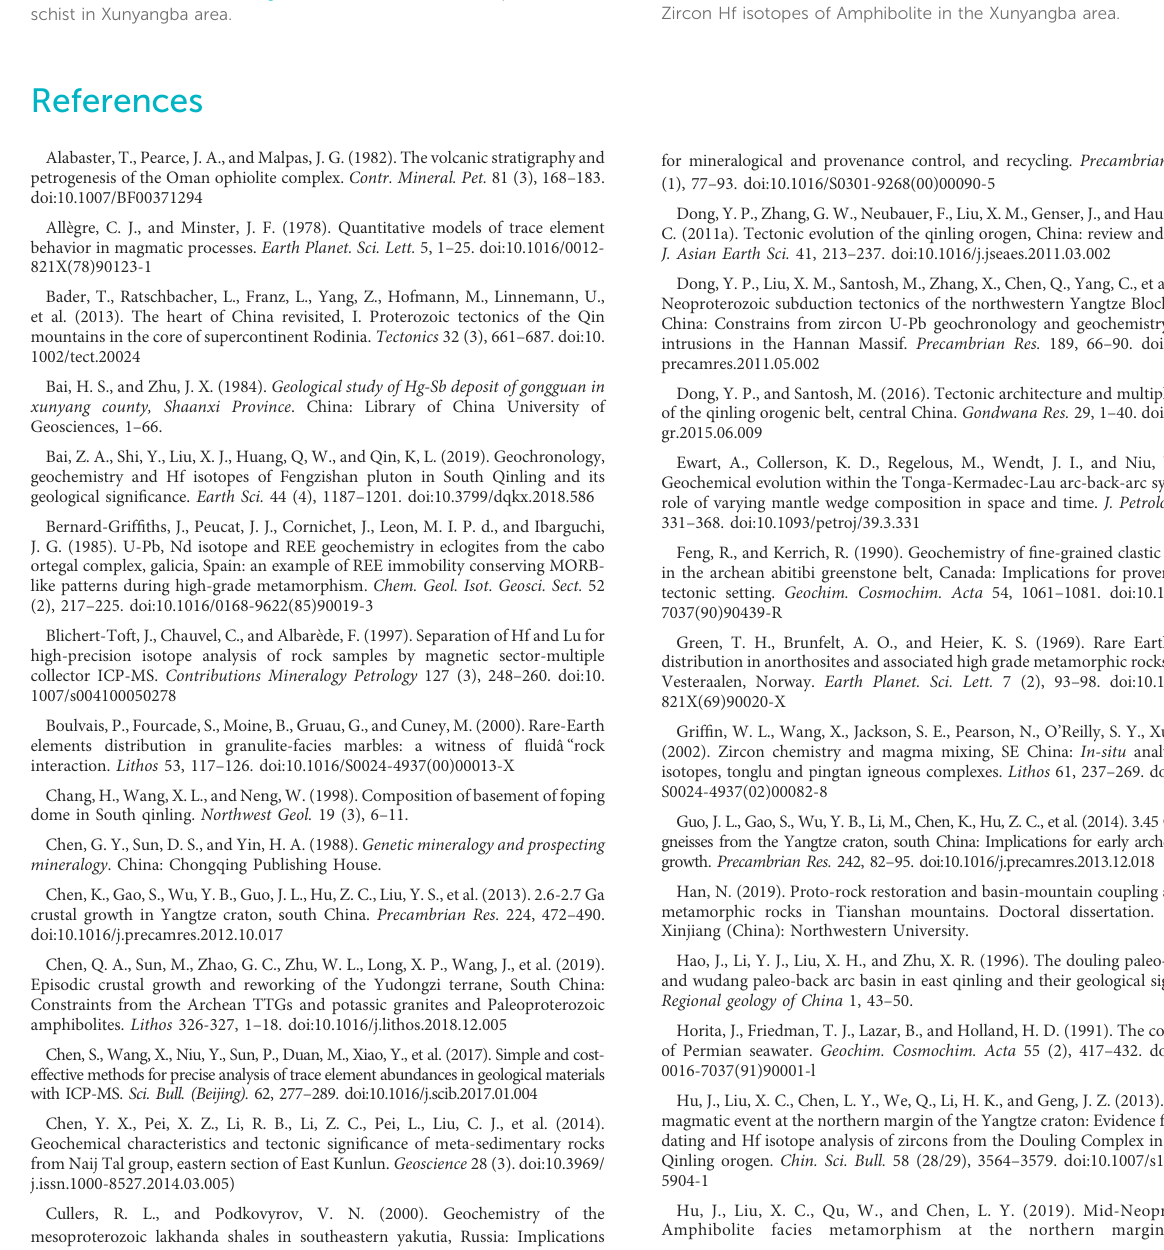
SUPPLEMENTARY FIGURE S2 SiO 2 -K 2 O/Na 2 O (modi fi ed from Roser and Korsh (1986), (1988)), black circle represents the schist in Xunyangba area. SUPPLEMENTARY FIGURE S3 Diagram of element variation. (Kongling group metamorphic rock data comes from Qiu et al. (2016); Yudongzi group metamorphic rocks data comes from Chen et al. (2019); Foping group data comes from Zhang et al. (2021). Note: unit of major elements: wt%, unit of trace elements: ppm. SUPPLEMENTARY APPENDIX SA Zircon LA-ICP-MS U-Pb data of amphibolite and schist in the Xunyangba